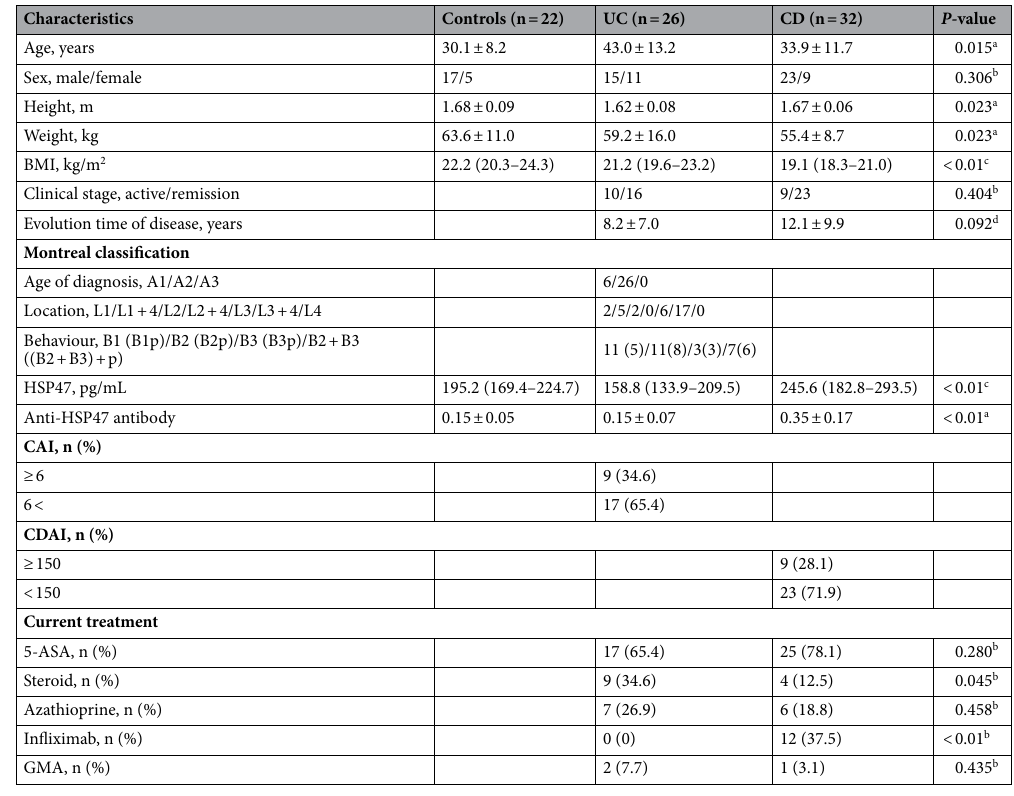
Table 1. Patient characteristics. Clinical active stage was defined as CAI > 4 for UC and CDAI > 150 for CD. Montreal classification of CD: A1, age < 16 years; A2, age 17–40 years; A3, age > 40 years. L1 ileal, L2 colonic, L3 ileocolonic, L4 isolated upper disease, B1 non-structing and non-penetrating, B2 structing, B3 penetrating, p perianal, UC ulcerative colitis, CD Crohn’s disease, BMI body mass index, HSP heat shock protein, CAI clinical activity index, CDAI Crohn’s disease activity index, GMA granulocyte–monocyte apheresis. a One-way analysis of variance; b Chi-square test; c Kruskal–Wallis test; d Student’s t